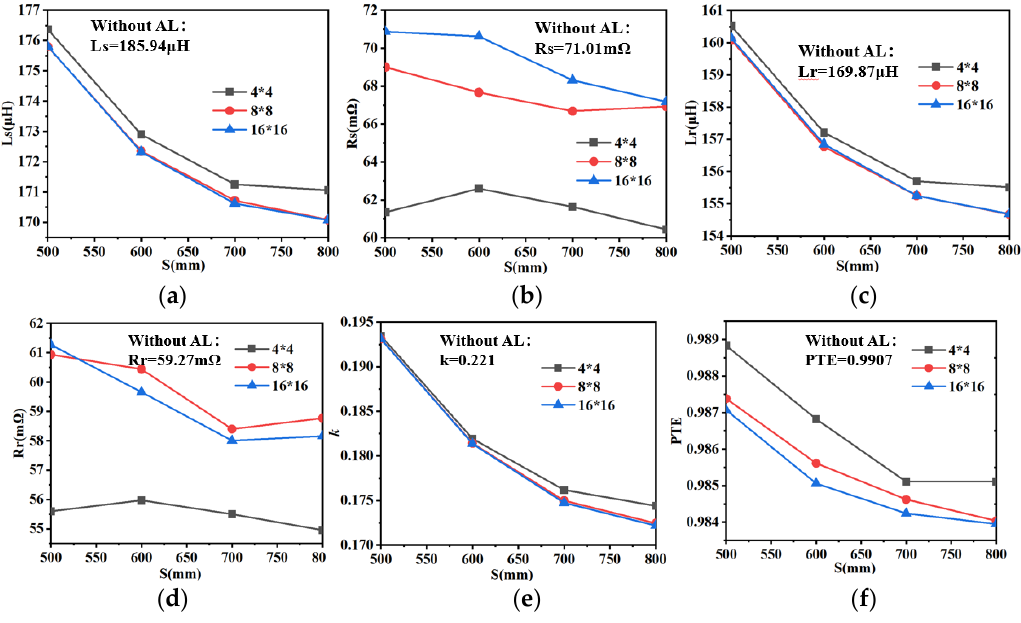
Figure 8. Influence of mesh aluminium plate size on impedance and transmission performance: ( a ) transmitting coil inductance; ( b ) transmitting coil resistance; ( c ) receiving coil inductance; ( d ) receiv- ing coil resistance; ( e ) coupling coefficient; ( f ) transmission efficiency.